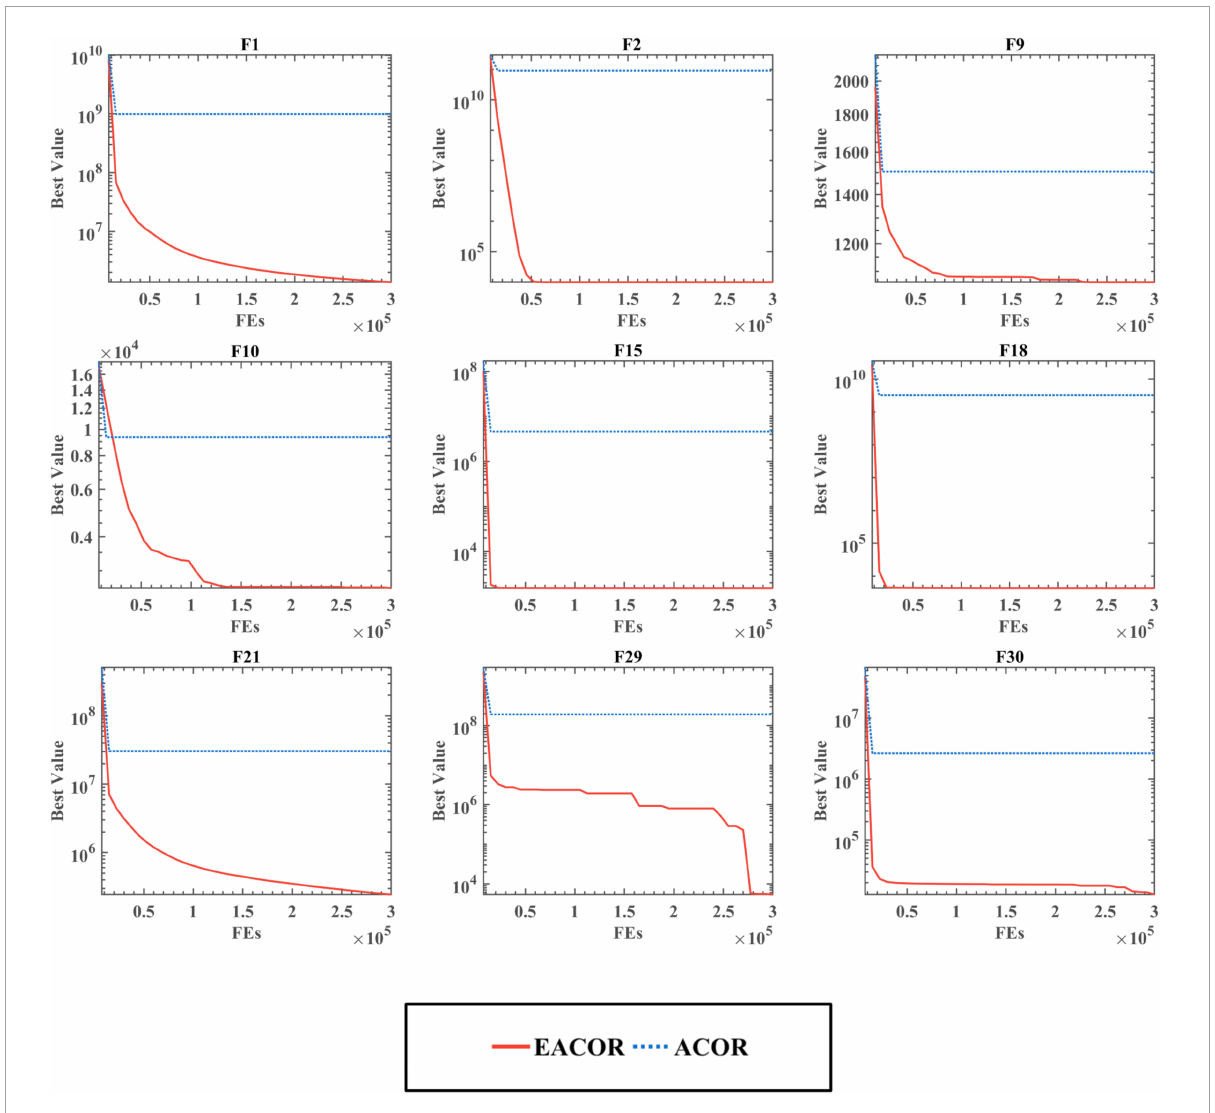
FIGURE8 Convergence curves of EACOR and ACOR at 50